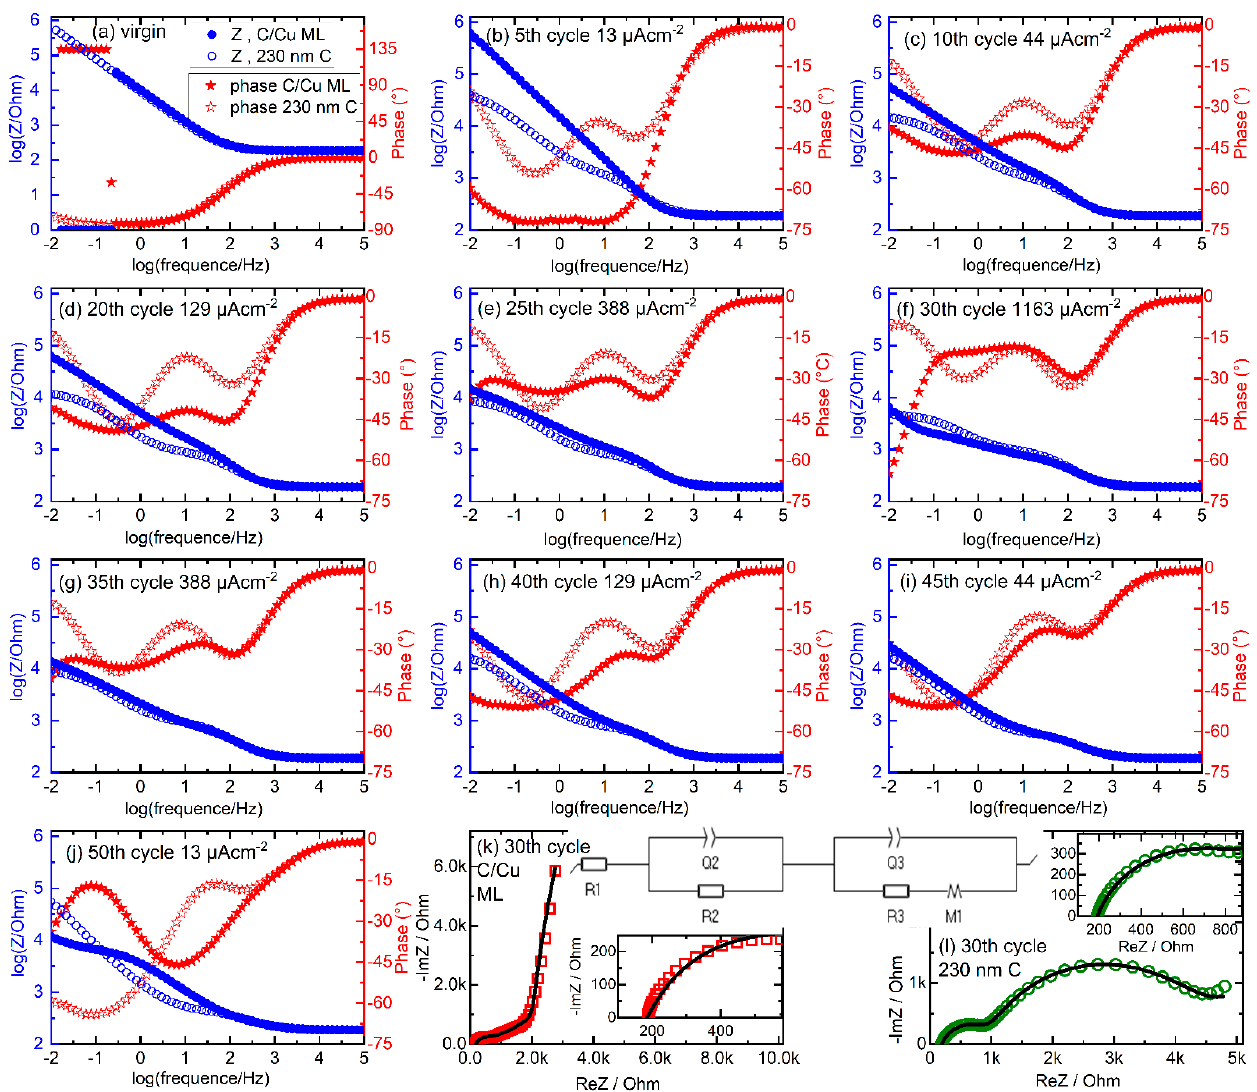
Figure 9. EIS data. ( a – j ) Frequency response of impedance (circles) and phase (stars) (Bode plot) obtained in the virgin state ( a ) and in the delithiated states of charge ( b – j ) of the C/Cu ML (filled symbols) and 230 nm carbon single film (unfilled symbols) during the rate capability experiments (Figures 3, 4 and 6–8). ( b ) after 5 cycles with 13 µAcm − 2 . ( c – j ) after subsequent 5 cycles with ( c ) 44 µAcm − 2 , ( d ) 129 µAcm − 2 , ( e ) 388 µAcm − 2 , ( f ) 1163 µAcm − 2 , ( g ) 388 µAcm − 2 , ( h ) 129 µAcm − 2 , ( i ) 44 µAcm − 2 , ( j ) 13 µAcm − 2 . ( k , l ) Complex plane (Nyquist) representation of EIS collected from the C/Cu ML (red squares in panel ( k )) and from the 230 nm carbon film (green circles in panel ( l )) electrode for the Bode plot of panel ( f ). The equivalent circuit used to analyze the measured EIS data is also drawn. The fitted curves are plotted with black lines. For better visualization, the inset figures present the EIS data in the high-frequency region. A color version of this figure can be viewed online.